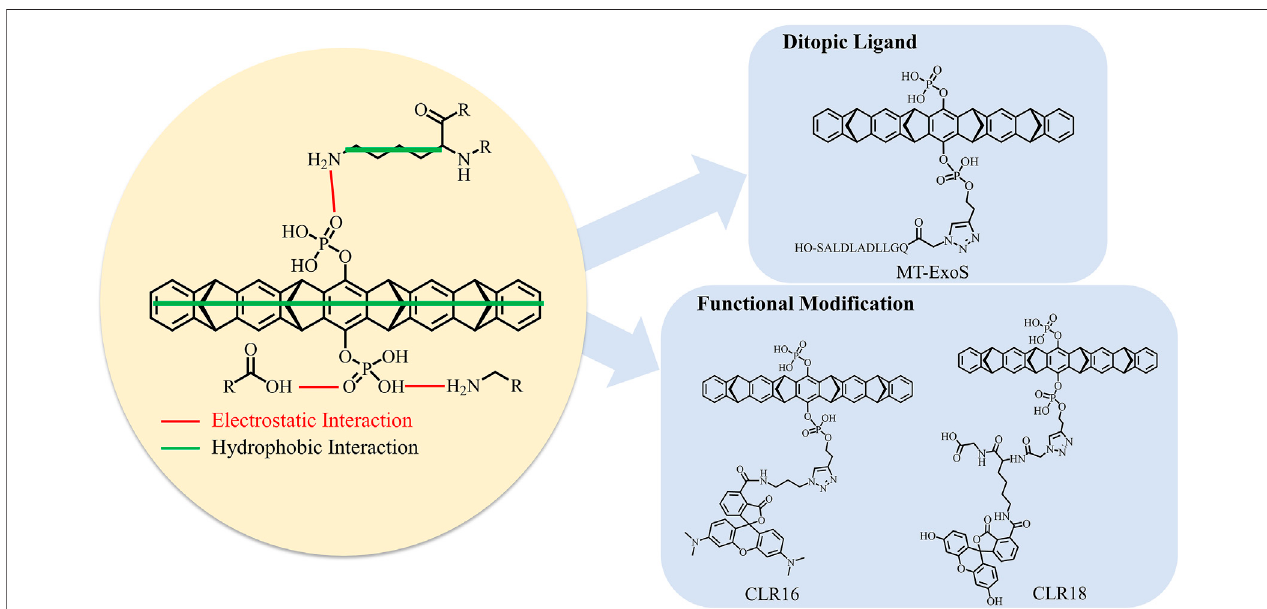
FIGURE 6 | Binding mechanism of tweezer CLR01 binding to lysine site on 14-3-3 σ and the optimization strategies of tweezer.